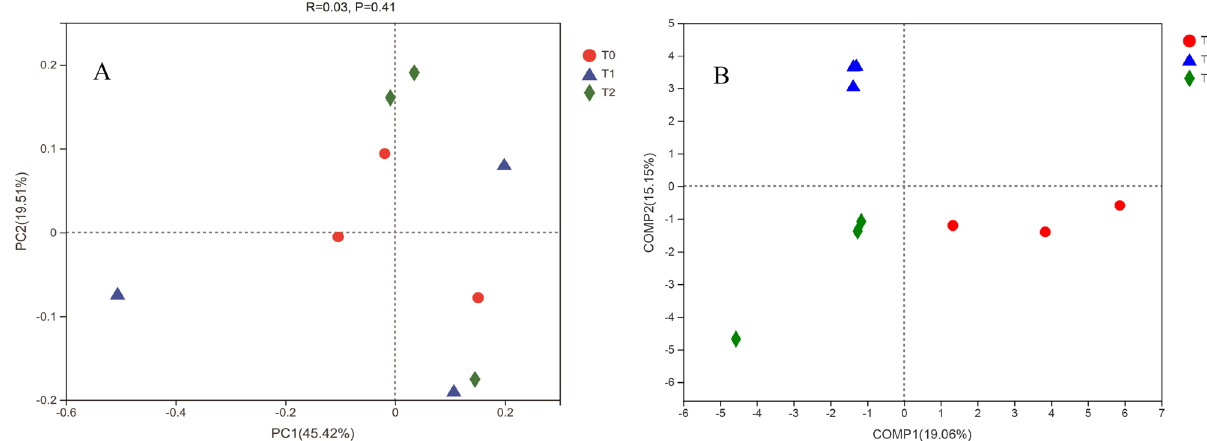
Figure 4. Comparison of the community structure of ammonia-oxidizing archaea (AOA) at the OTU level under different fertilization and irrigation regimes using principal coordinates analysis (PCoA) (A) and partial least squares discriminant analysis (PLS—DA ) (B) based on Bray–Curtis distance, respectively. Notes : R and P are from ANOSIM analysis comparing the beta diversity associated with T 0 , T 1 , and T 2 treatments. T 0 = Traditional irrigation; T 1 = Traditional irrigation and fertilization practice; T 2 = Water-saving irrigation and optimizing